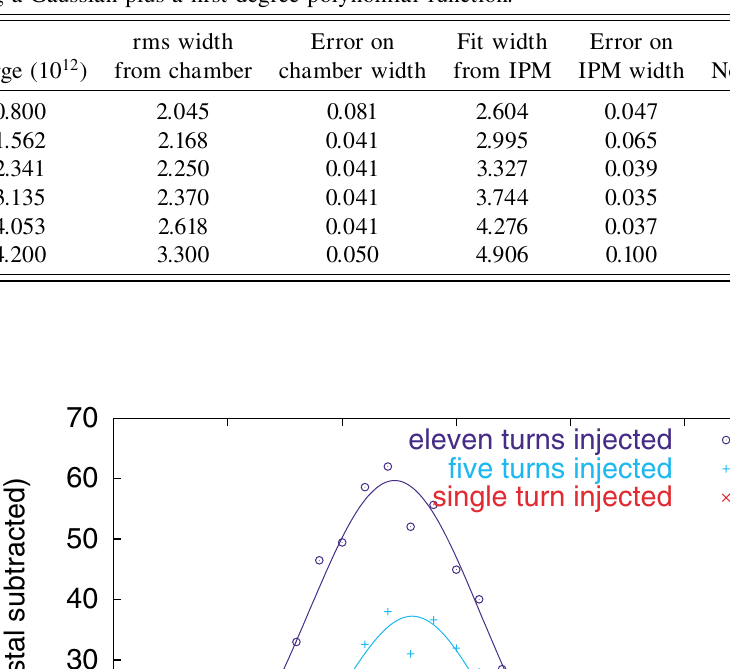
TABLE III. MI-8 chamber data. The IPM width is extracted by a fit to the IPM profile data using a Gaussian plus a first degree polynomial function.